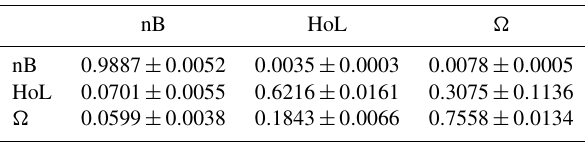
Table 3. Probability estimates ± SE for the three-state model. Prob- abilities give the transition to the state given in the column condi- tioned on the state given in the row. nB